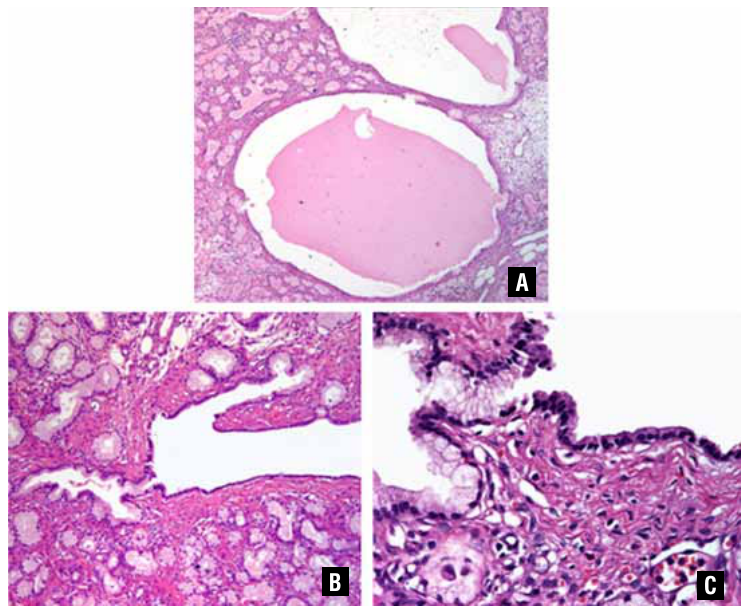
Figure 3 - (A) Hematoxylin and eosin. Cystic Cowper’s glands, alternating with normal glands (10x); (B) Cystic dilation of Cowper’s gland (10x); (C) High power view showing the transition from Cowper’s gland normal epithelium to simple columnar epithelium lining the cystic portion (40x).